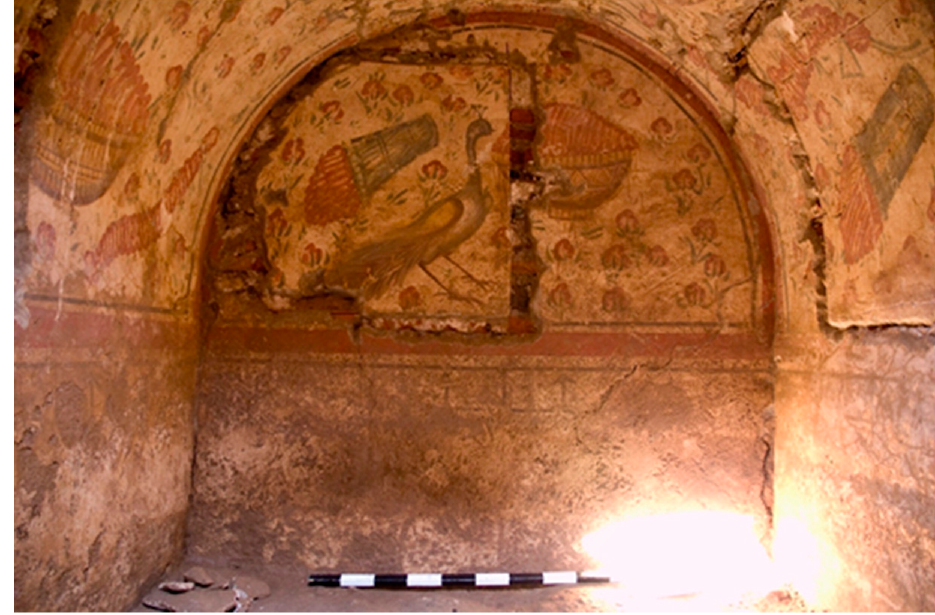
Figure 1. Sardis, Tomb 07.3 (Appendix A.5), west wall. © Archaeological Exploration of Figure1. Sardis, Tomb07.3(AppendixA.5), westwall. © ArchaeologicalExplorationofSardis / President Sardis/President and fellows of Harvard College. and fellows of Harvard